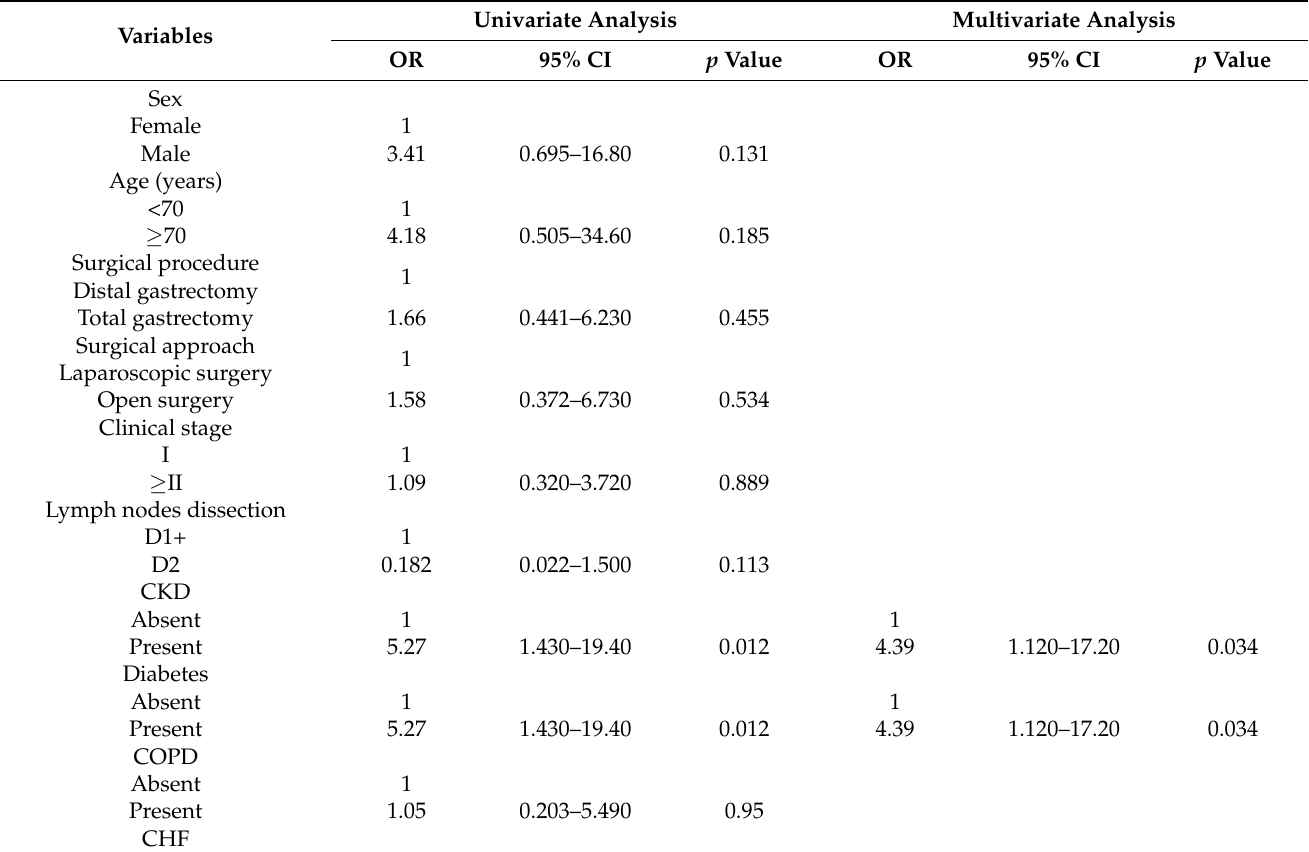
Table 4. Results of analyses of infectious complications in patients with